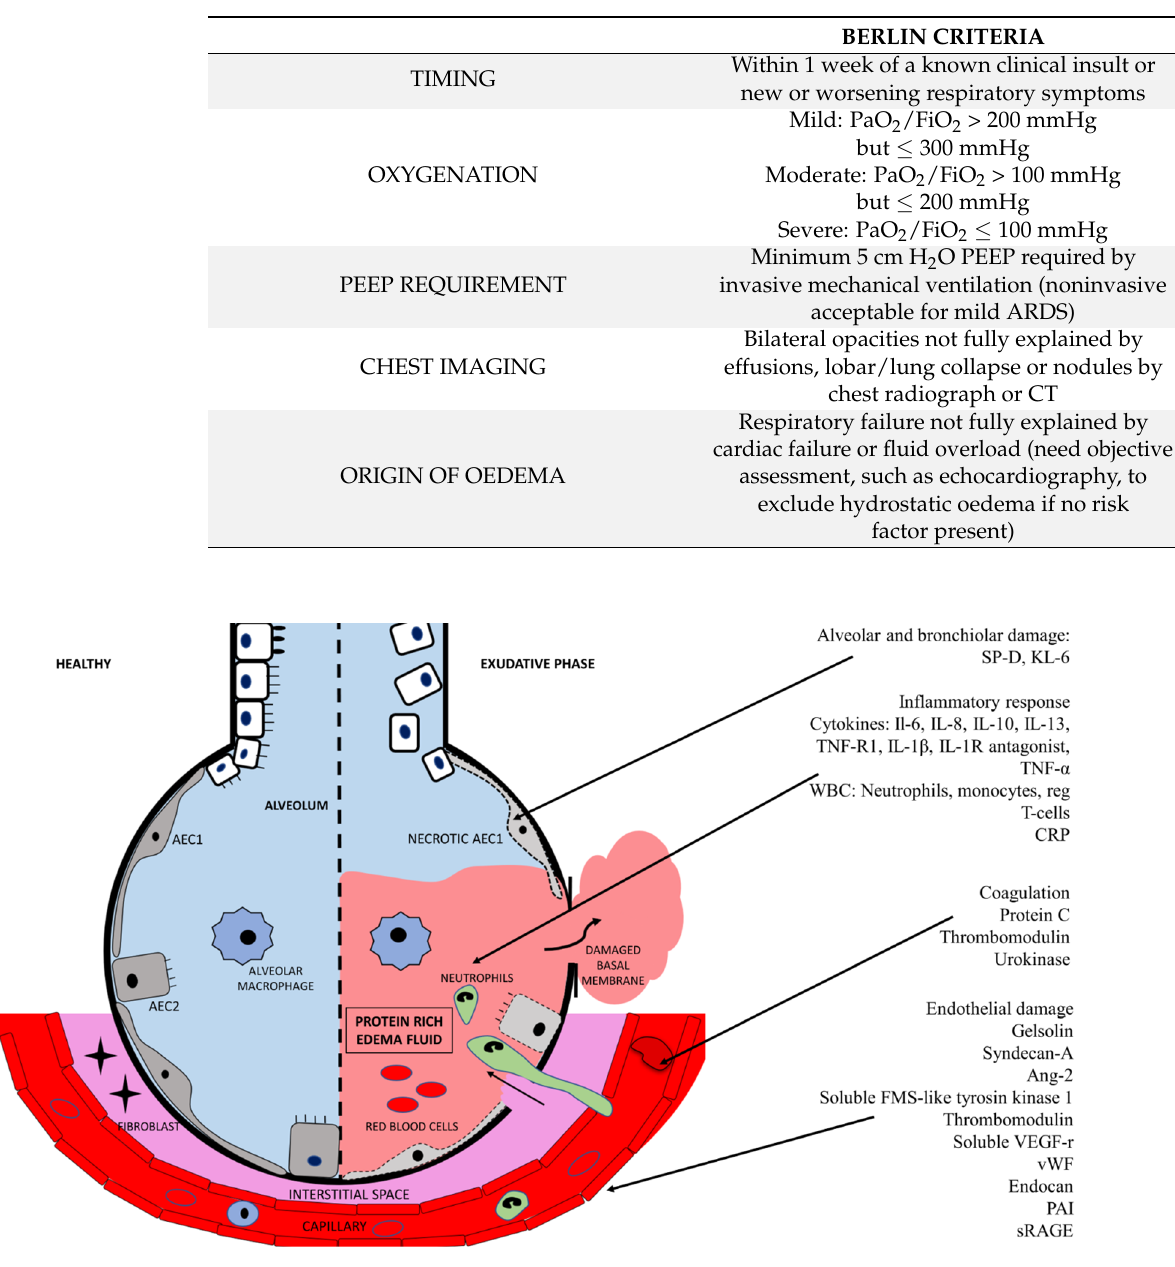
Figure 1. Biomarkers of acute respiratory distress syndrome organised in alveolar/bronchiolar damage, inflammatory response, coagulation, and endothelial